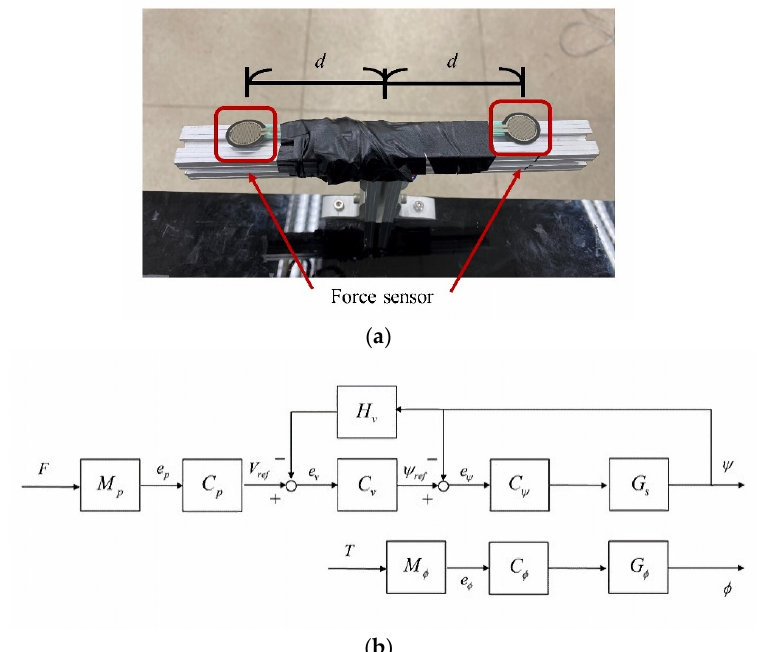
Figure 13. Walking assistance of the TWIP robot: ( a ) Force sensors on the handrail; ( b ) The decoupled control loop.